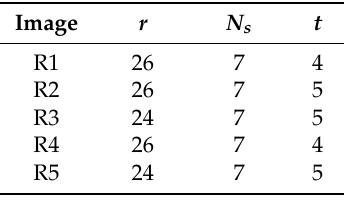
Table 4. Critical parameter settings of our